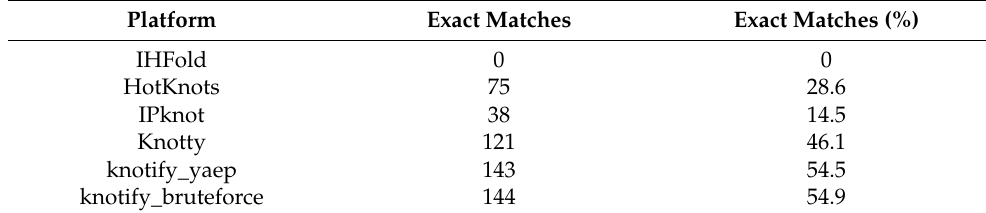
Table 3. Predicting pseudoknot location in entire dataset.